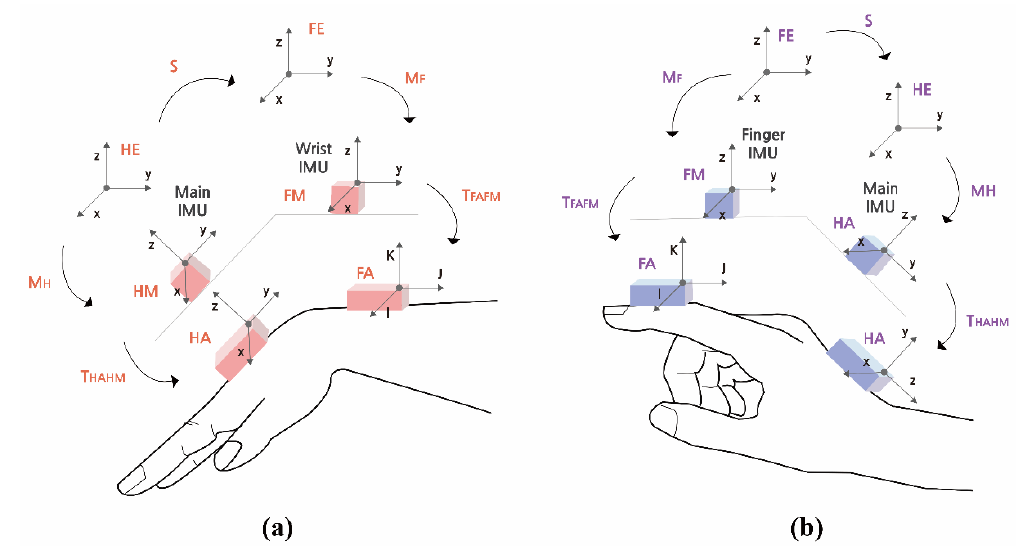
Figure 4. Algorithm for joint angle estimation between adjacent segments: ( a ) the wrist and ( b ) finger.